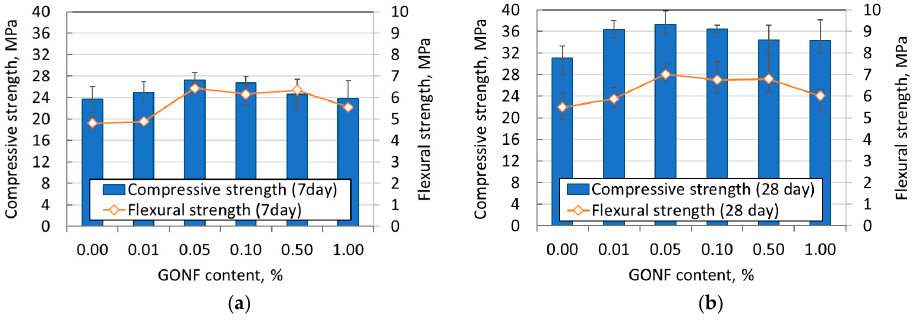
Figure 7. Compressive and flexural strength results of GONF-combined paste with Dry-mix design method. ( a ) Mechanical properties of GONF-combined paste with Dry-mix design (PD) (7 days); ( b ) Mechanical properties of PD (28 days).